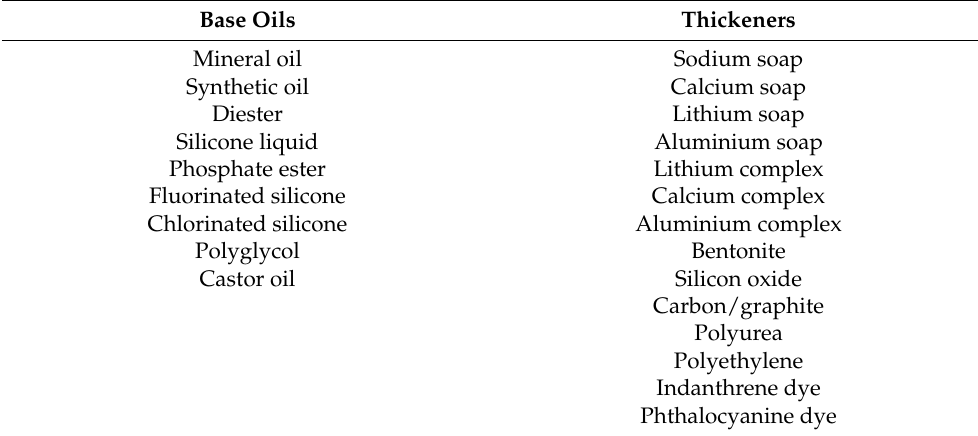
Table 10. Most-used base oils and thickeners for lubricating greases. Base Oils Mineral oil